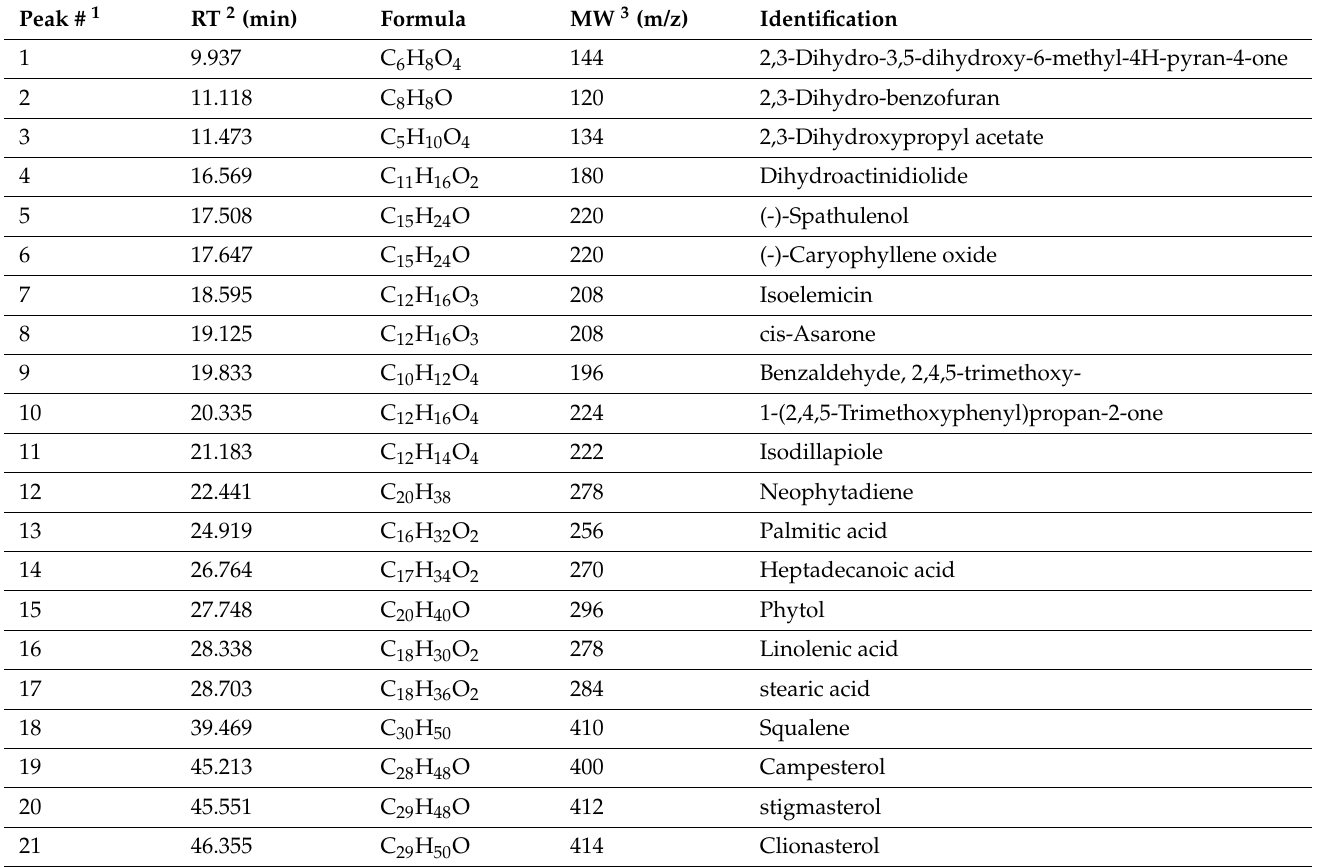
Table 1. Characterization of chemical constituents in EPF by GC-MS analysis.